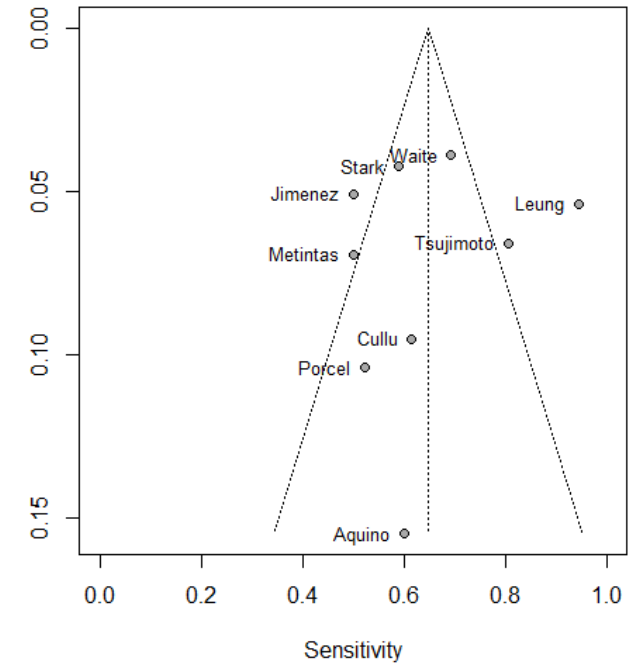
Figure A6. Scatter plot of sensitivities of the studies (only informative CT findings) compared to their standard error. The summary estimate is based on a random effects model.